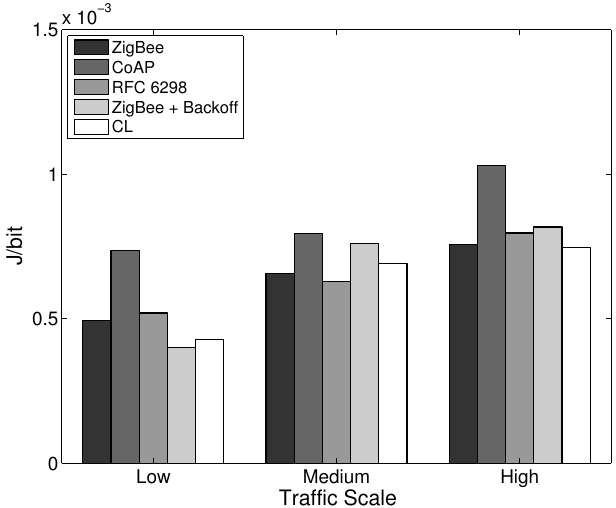
Figure 18. Energy efficiency for different RTO